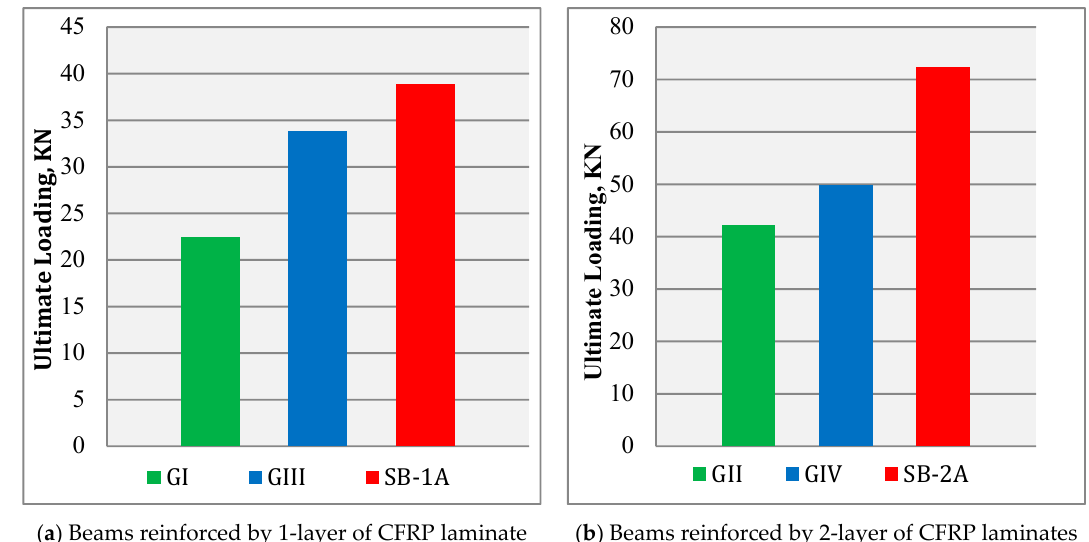
Figure 16. Comparison of experimental and analysis results.